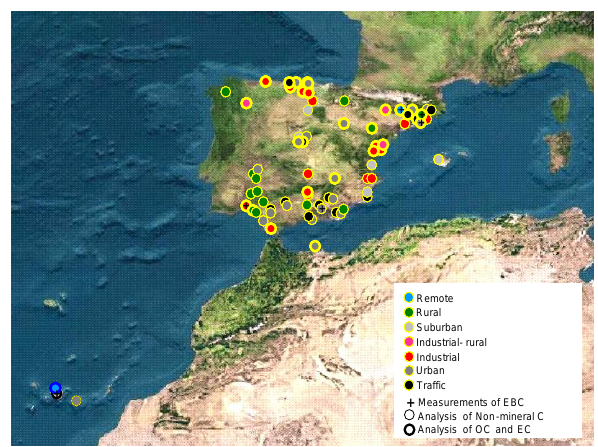
Figure 1. Location of the monitoring stations across mainland Spain, the Balearic Fig. 1. Location of the monitoring stations across mainland Spain, and Canary Archipelagoes and the Spanish Northern African territories from where during the period 1999-2011 data on nmC, OC, EC and EBC were obtained. the Balearic and Canary Archipelagoes and the Spanish northern African territories from where data on nmC, OC, EC and EBC were obtained during the period